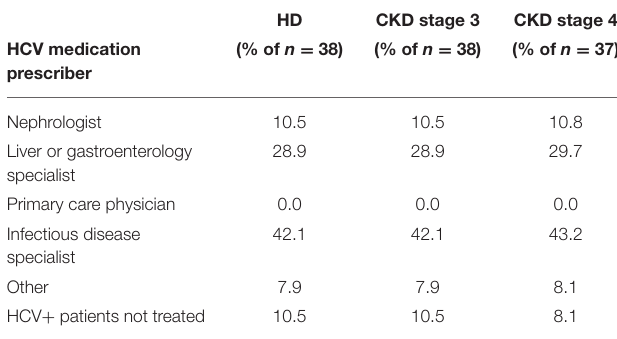
TABLE 8 | Estimated % of clinic HCV + patients that have been treated with anti-HCV medications, by ESKD stage (China Medical Director HCV survey, 2021).